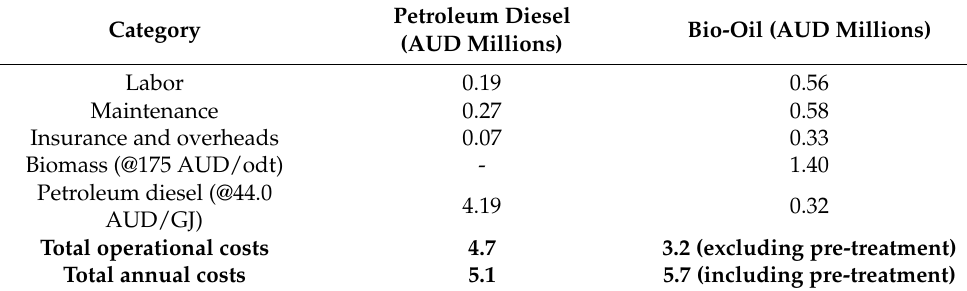
Table 3. Operational costs associated with running a diesel generator electricity plant with petroleum diesel and biomass converted to bio-oil as its fuel source (exclusive of pre-treatment costs). The final row is the total overall costs of the plant including, pre-treatment, capital, and operational costs. All values given in AUD